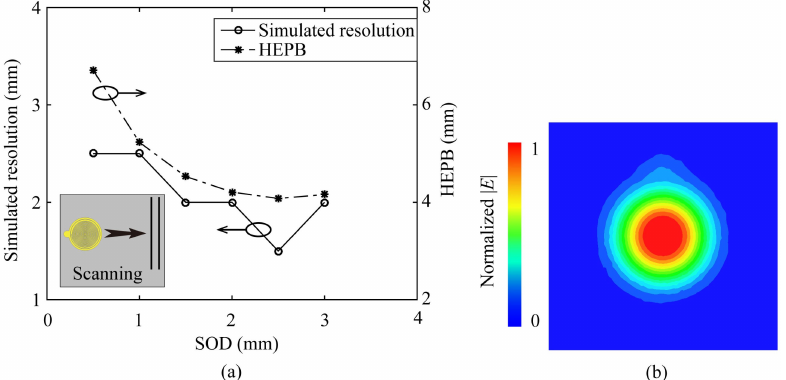
Figure 8. ( a ) The HEPB variation and the simulated resolution evaluation for di ff erent SODs, and the simulated resolution is obtained by scanning two adjacent conducting wires; ( b ) The electric near field distribution in the measuring plane of a 1 mm